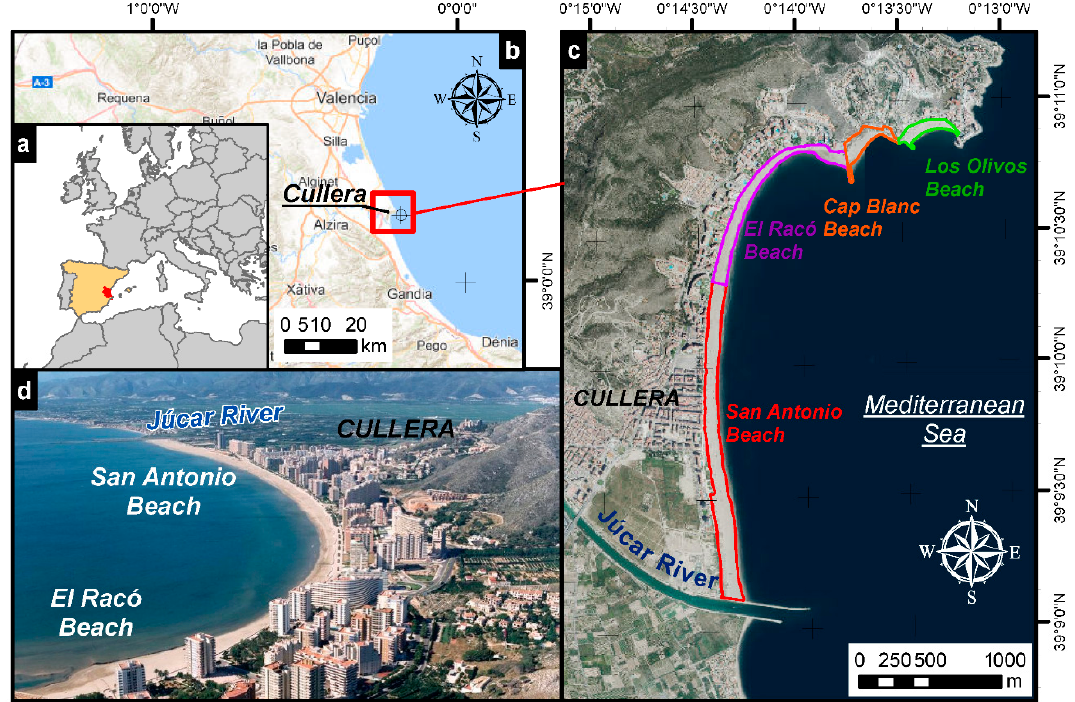
Figure 1. ( a ) Study area in Valencia, Spain. ( b ) Detail of the study area, with the position of the SIMAR Node used in the wave calculations. ( c ) Location of the beaches and significant elements on the coast of the Bay of Cullera. ( d ) Aerial image of the Bay of Cullera.